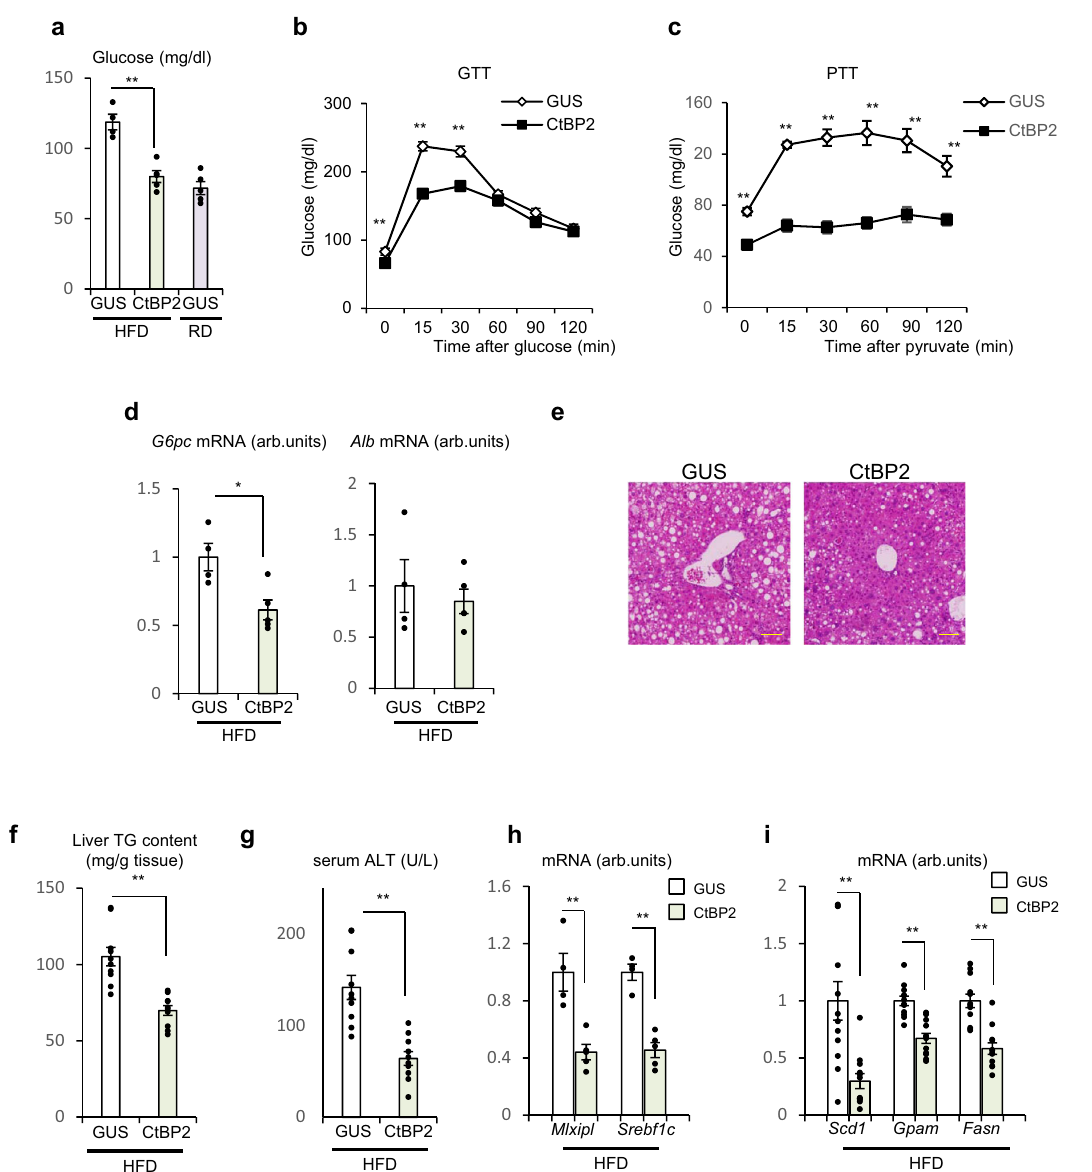
Fig. 6 CtBP2 gain of function in liver ameliorates diabetes and hepatic steatosis in obese mice. CtBP2 was exogenously expressed in the liver of diet- induced obese mice by adenoviral transduction (AdCtBP2), along with its control (AdGUS). Animals were analyzed after 3 – 7 days of transduction ( a – d, h overnight fasted, e – g , i 6-h fasted). a Blood glucose levels ( n = 4 for GUS/HFD, n = 5 CtBP2/HFD, and n = 5 for GUS/lean, biologically independent animals, p = 7.8 × 10 − 4 ). HFD high-fat diet, RD regular diet. b Glucose tolerance test (GTT, n = 10, biologically independent animals, p -values are 8.8 × 10 − 3 for 0 min, 1.0 × 10 − 8 for 15 min, 1.4 × 10 − 4 for 30 min). c Pyruvate tolerance test (PTT, n = 9 for GUS, n = 10 for CtBP2, biologically independent animals, p values are 7.6 × 10 − 6 for 0 min, 2.5 × 10 − 9 for 15 min, 1.1 × 10 − 7 for 30 min, 2.6 × 10 − 6 for 60 min, 4.9 × 10 − 5 for 90 min, 3.0 × 10 − 4 for 120 min). d Gene expression in liver ( n = 4 for GUS, n = 5 for CtBP2, biologically independent animals, p = 0.015). e Representative hematoxylin and eosin stained sections of liver. Yellow bars indicate 100 μ m. f Liver triglyceride (TG) content ( n = 10, biologically independent animals, p = 6.6 × 10 − 5 ). g Serum ALT levels ( n = 10, biologically independent animals, p = 7.4 × 10 − 5 ). h , i Lipogenic gene expression ( n = 4 ( h ), n = 10 ( i ), biologically independent animals, p = 3.8 × 10 − 3 ( Mlxipl ) and 2.1 × 10 − 4 ( Srebf1c ), 8.3 × 10 − 4 ( Scd1 ), 1.7 × 10 − 5 ( Gpam ) and 2.0 × 10 − 5 ( Fasn ), respectively). Data are expressed as the mean ± SEM. * and ** denote p < 0.05 and p < 0.01 evaluated by unpaired two-tailed Student ’ s t -test, respectively. Source Data are provided as a Source Data fi